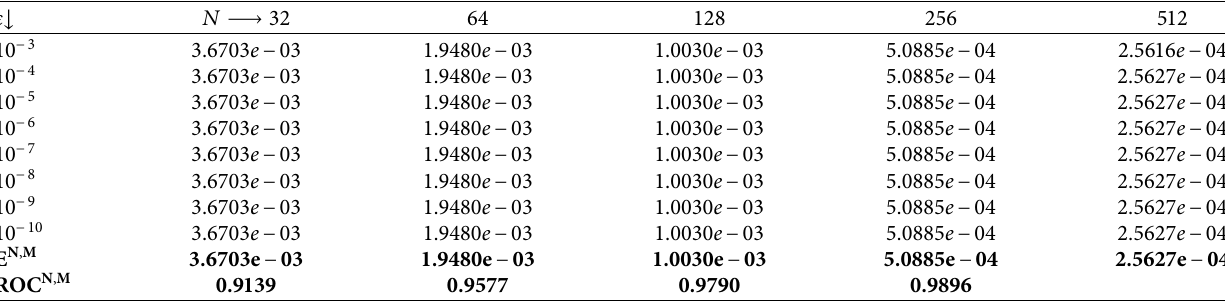
Table 3: Computed maximum point-wise errors, ε -uniform errors ( E N,M ) and the ε − uniform rate of convergence ( ROC N,M ) for Example 2 when M � N , before extrapolation.